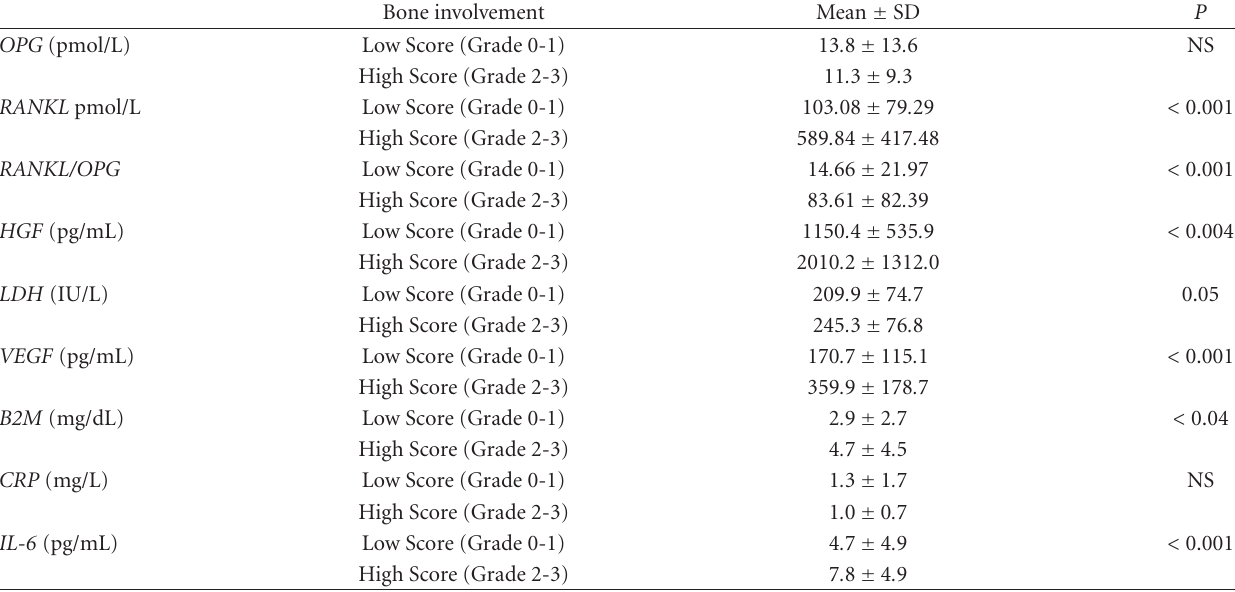
Table 3: Mean ± SD values of the measured parameters in the group of MM patients according to the skeletal involvement.